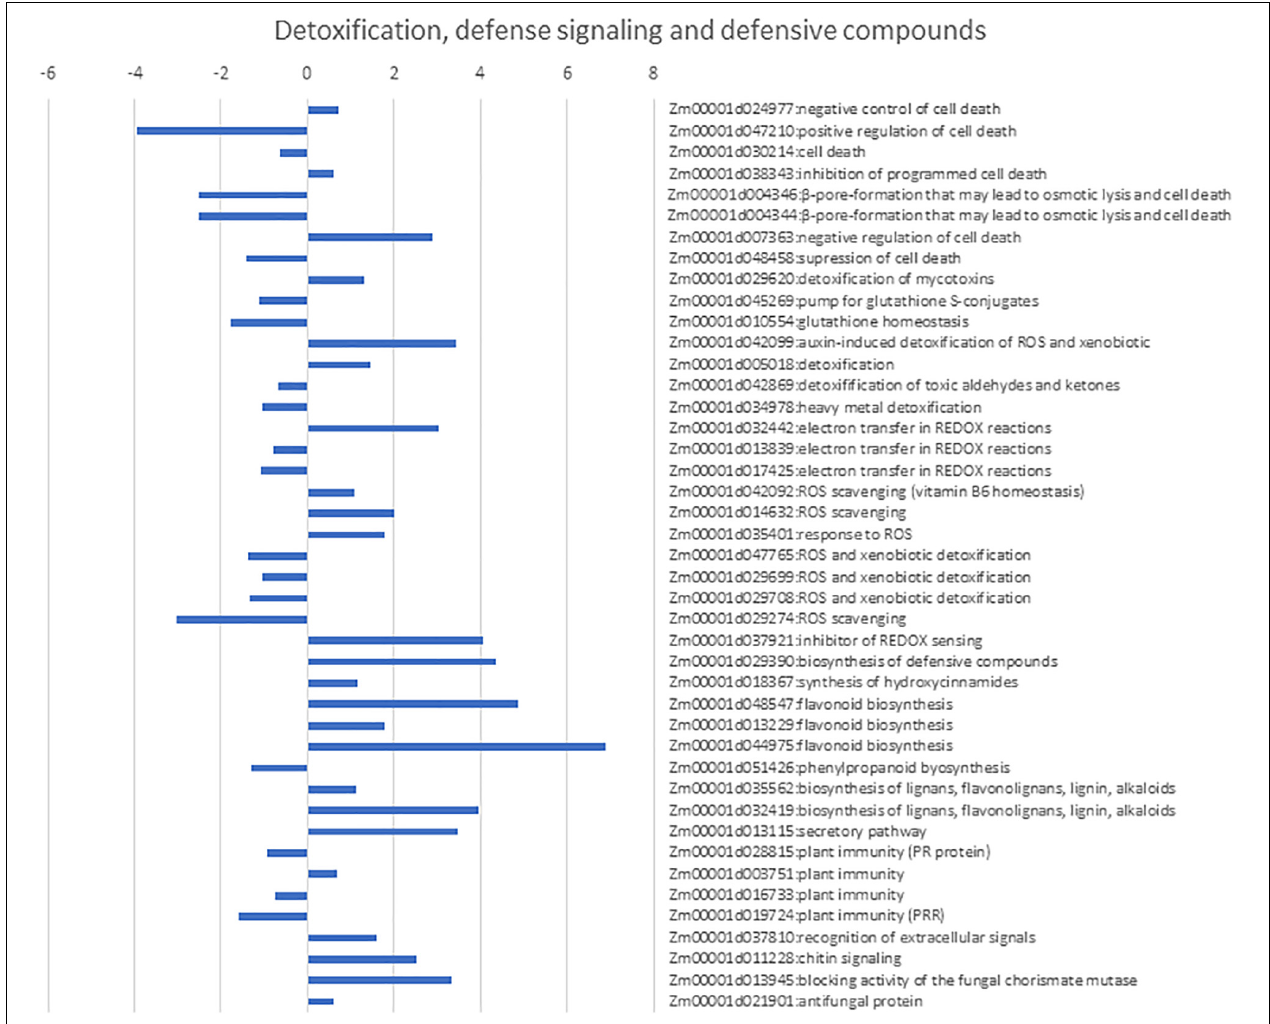
FIGURE 5 | Expression Log 2 fold change between inbred bulks resistant and susceptible to Fusarium ear rot and kernel contamination with fumonisins for differentially expressed genes (DEGs) related to detoxification, defense signaling, and biosynthesis of defensive